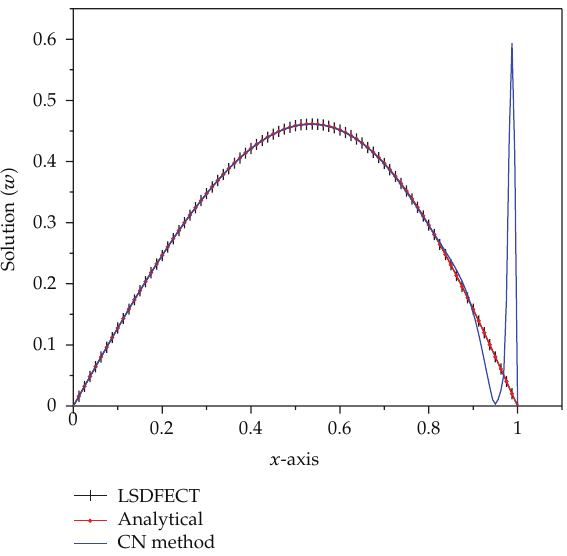
Figure 2: Comparison of the numerical solution by our method (cid:2) LSDFECT (cid:3) , CN method, and exact solution of Problem 2 at di ff erent space points for N (cid:8) 80, ν d (cid:8) 2, and k (cid:8) 0 . 01 at T (cid:8) 0 .